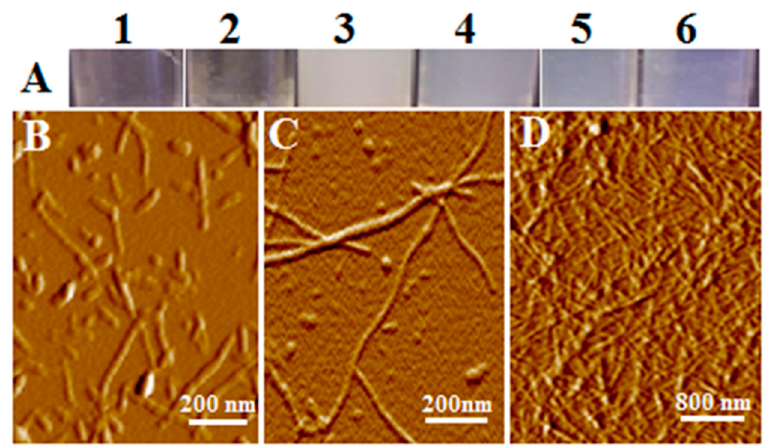
Figure 1. Atomic force microscopy (AFM) images of lysozyme fiber solution and gel. ( A ) visual appearance of the fiber solution ( 1 and 2 ) and gel ( 3 to 6 ). Gels appear in two colors, white (vial 3 ) and light blue (vials 4 – 6 ). Fiber solution and gels were formed by incubation of lysozyme under different concentrations at 55 °C, and pH 2.5, adjusted with HCl (vial 1 , 2 , 5 , 6 ) and pH 3.0 (vial 3 and 4 ). Vials ( 1 ) 10 mg/mL; ( 2 ) 20 mg/mL; ( 3 ) 40 mg/mL; ( 4 ) and ( 5 ) 70 mg/mL; ( 6 ) 100 mg/mL. ( B–D) Representative AFM images are presented: ( B ) solution from vial 1 ; ( C) solution of gel diluted in water; ( D ) gel. Colloidal spheres, beaded chains, and the unbranching, linear morphology of the early stage fibers shown in panels B and C suggest a linear aggregation pathway. Panel D reveals a dense network of fiber structure piled on top of each other.